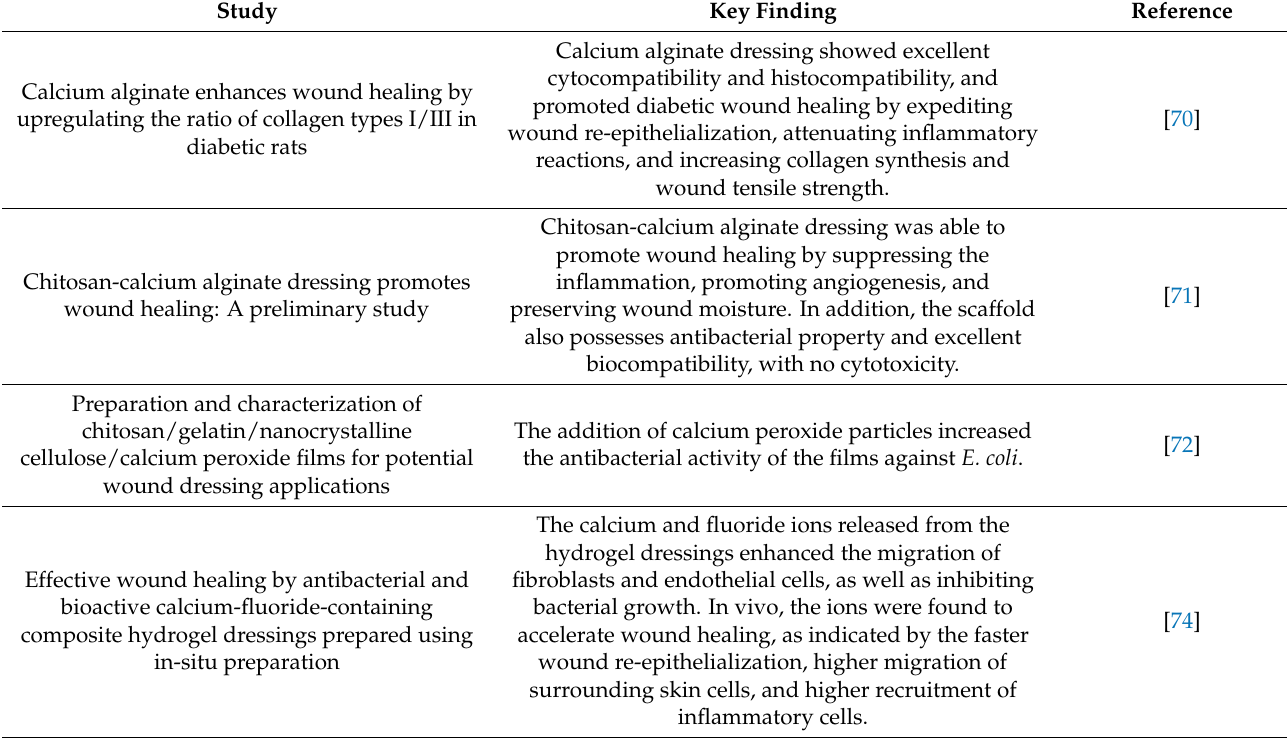
Table 2. Studies using calcium-based dressings to promote wound